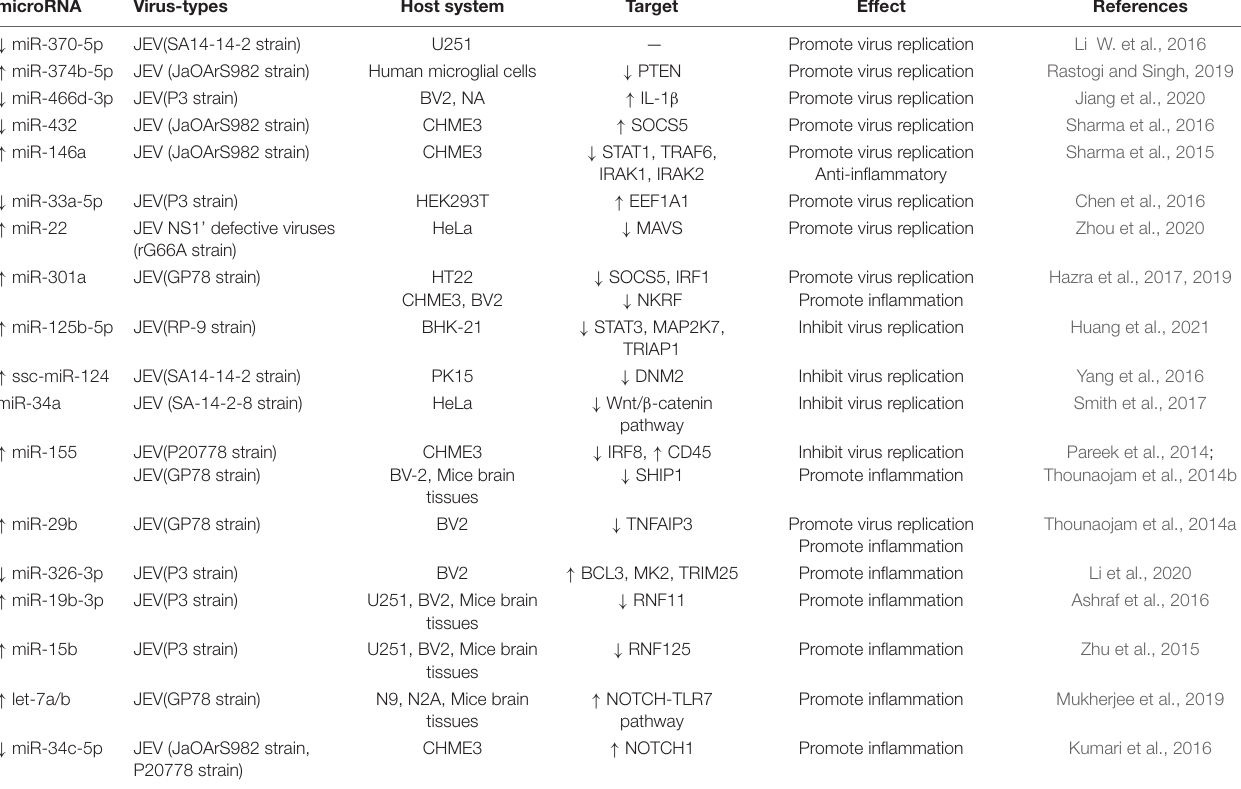
TABLE 2 | Differentially expressed miRNAs involved in JEV infection and their targets a